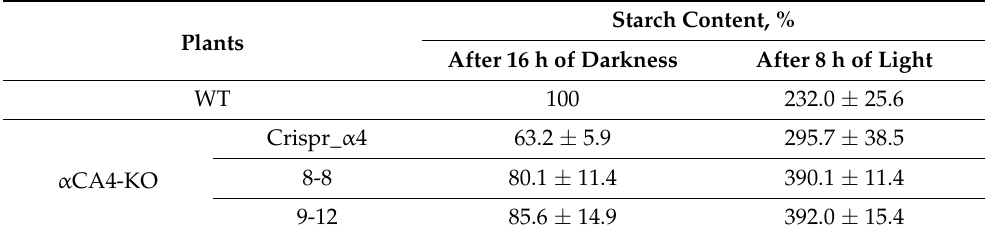
Table 1. The starch content in leaves of WT Arabidopsis thaliana and mutant plants with knocked out At4g20990 gene encoding α CA4 (lines Crispr_ α 4, 8-8 and 9-12) measured at the beginning of the light day (after 16 h of darkness) and at the end of the light day (after 8 h of light). The 100% value is the starch content in the WT leaves at the beginning of the light day (1.17 mg/g of fresh leaves weight). Starch Content, % Plants After 16 h of Darkness After 8 h of Light WT 100 232.0 ± 25.6 Crispr_ α 4 63.2 ± 5.9 295.7 ± 38.5 8-8 80.1 ± 11.4 390.1 ± 11.4 α CA4-KO 9-12 85.6 ± 14.9 392.0 ±